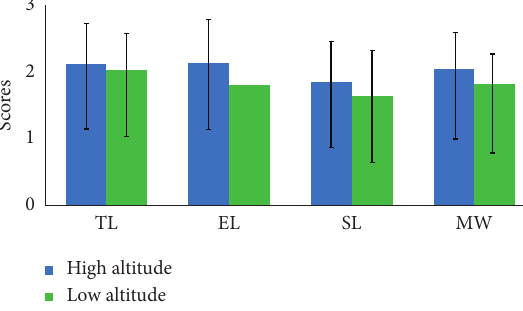
Figure 1: Scores of mental workload.